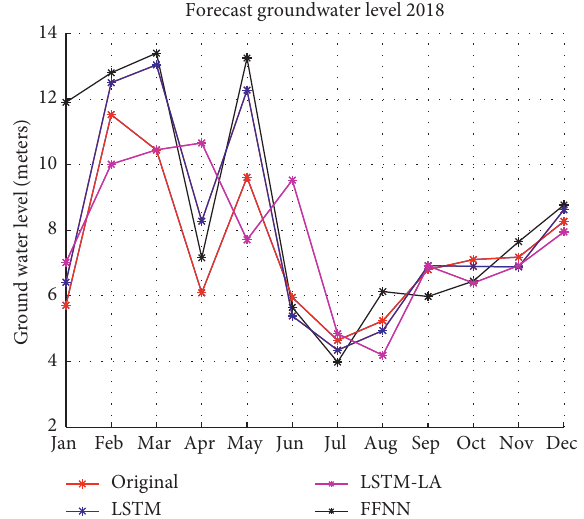
Figure 6: Plot for RMSE, MSE, and MAE for the hybrid LSTM-LA, LSTM, and FFNN models.